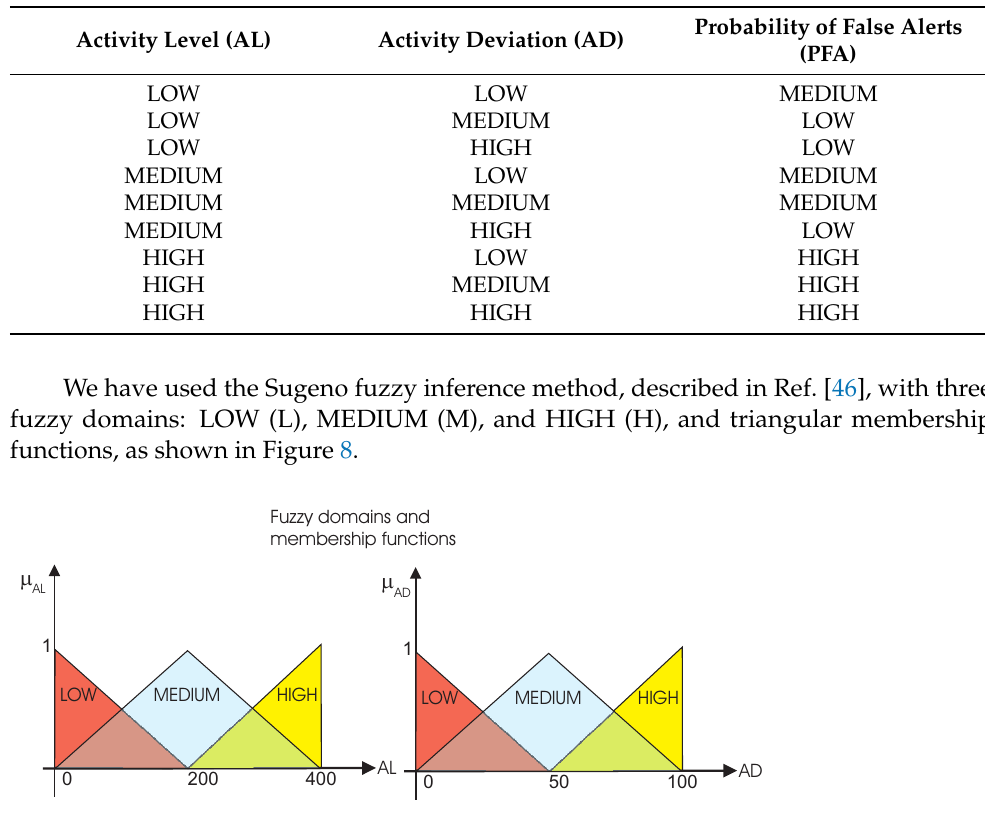
Figure 8. Fuzzy domains (LOW, MEDIUM, HIGH) and membership functions (µ) for AL and AD, used to compute the probability of false alerts (PFA).